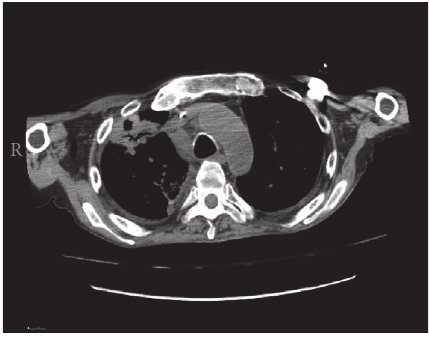
Figure2:Chestcomputedtomographyscanshowingcavitarylesion in the right lung